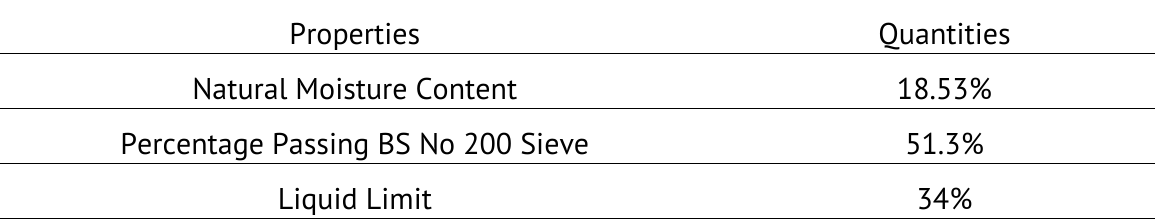
Geotechnical properties of the unstabilized lateritic